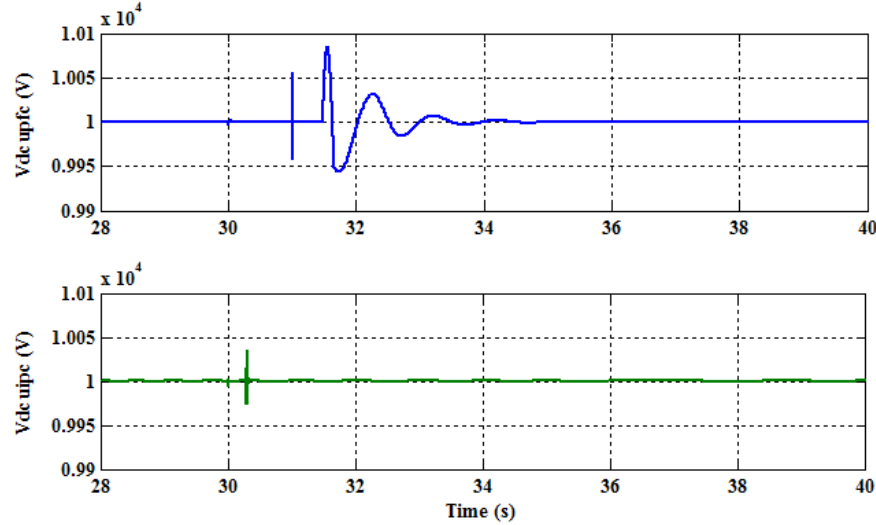
Figure 8. DC-link voltage for the UPFC and UIPC.